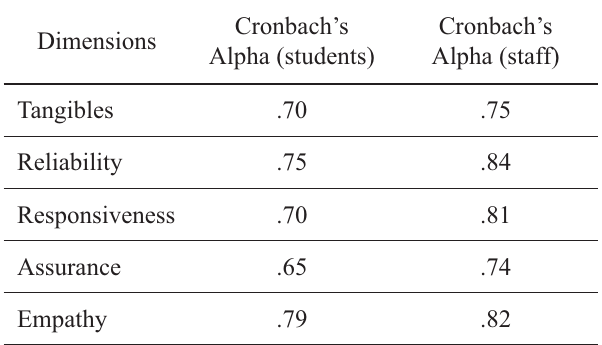
Table 2. Cronbach’s alphas of the SERVQUAL dimensions